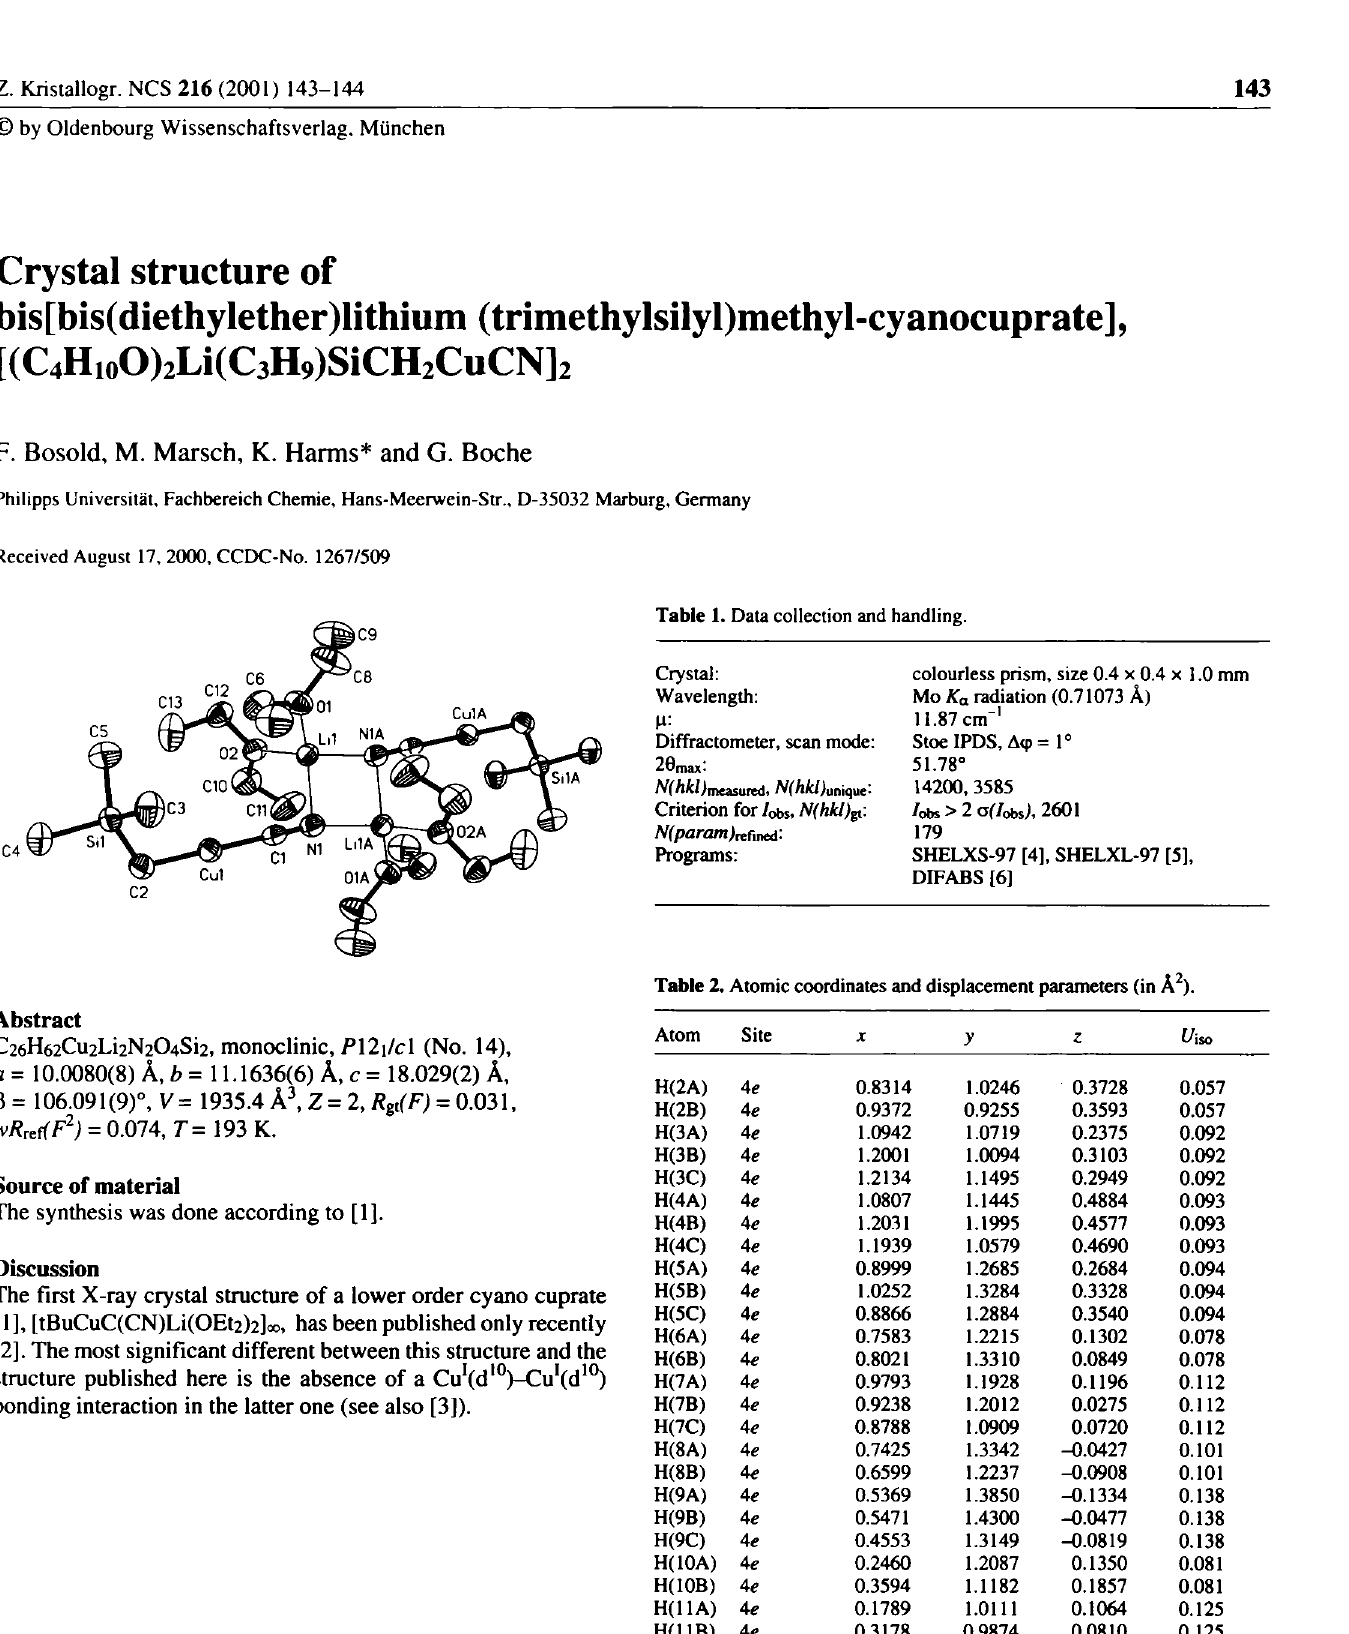
Table 2. Atomic coordinates and displacement parameters (in Ä 2